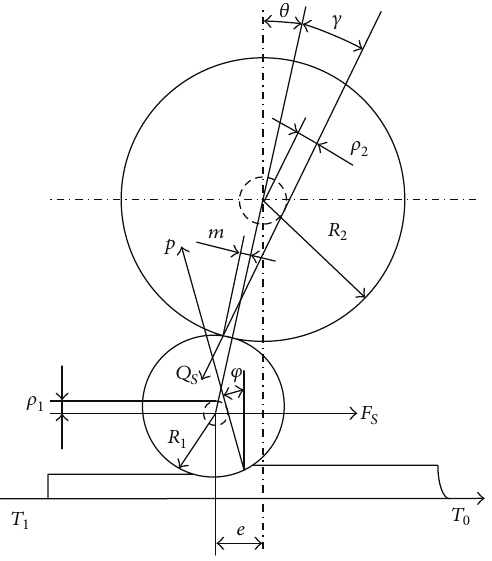
Figure 1: Upper roll system force